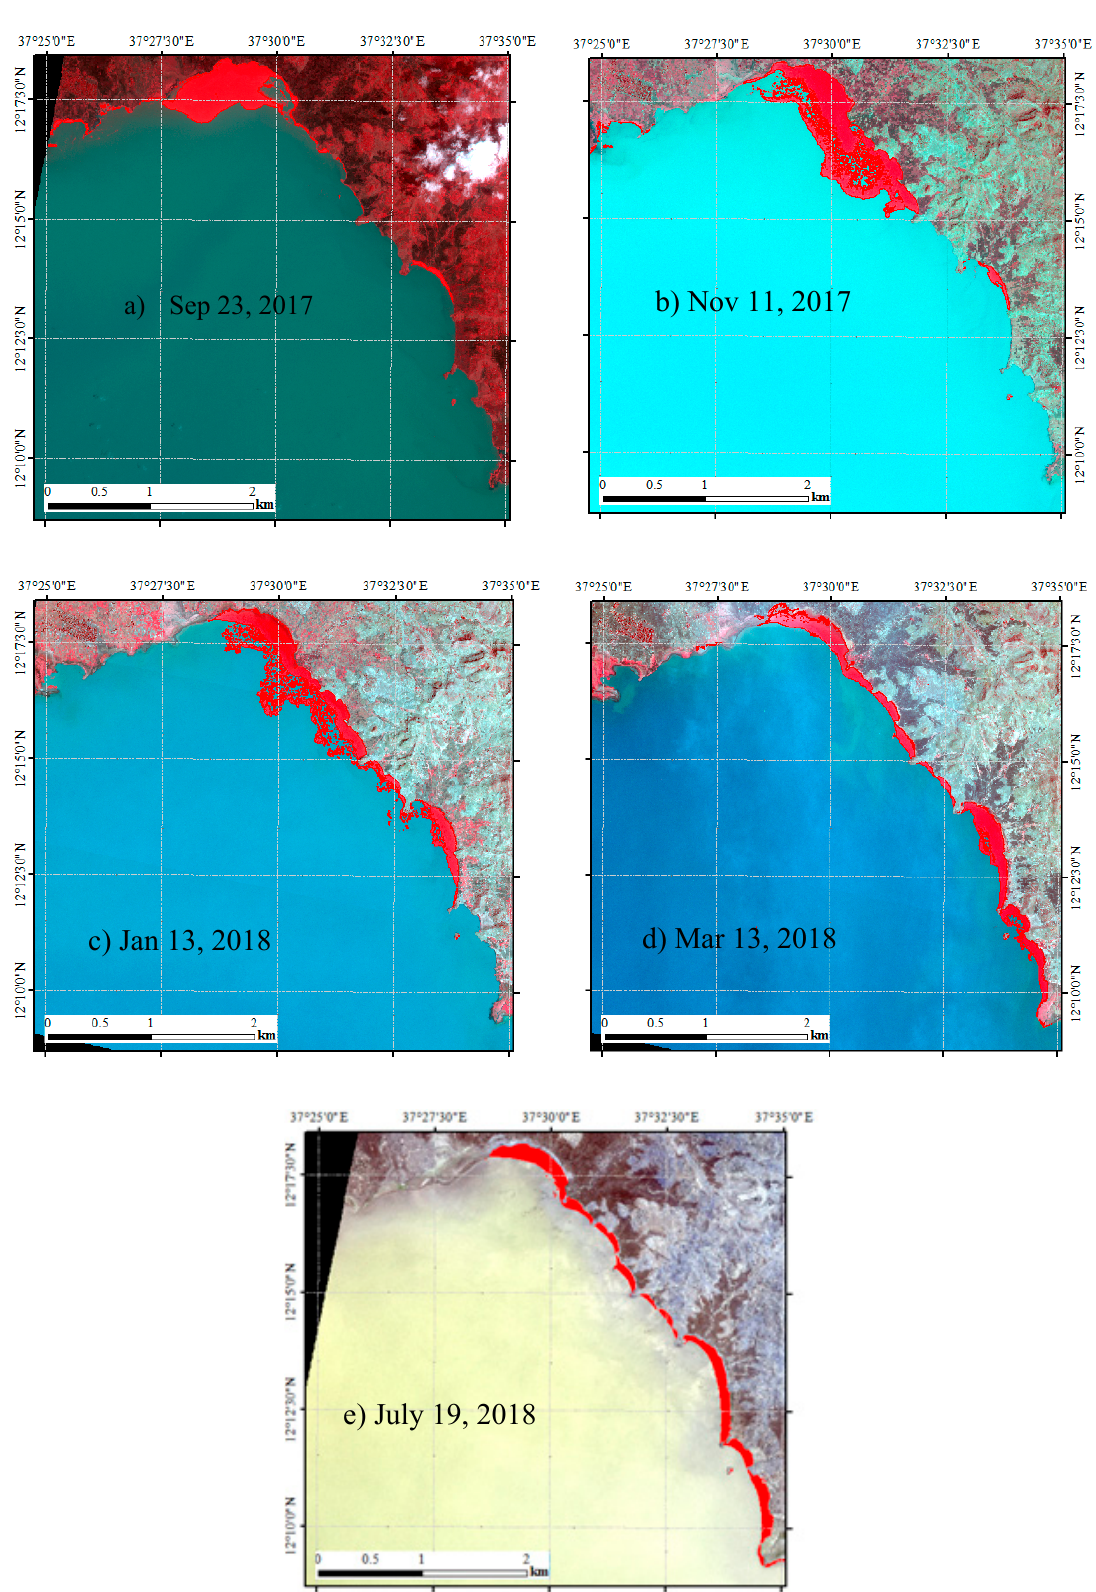
Figure 7. A false-color composite of PlanetScope image and spatial location of the water hyacinth infested area. Supervised classification of ( a ) September 23, 2017, ( b ) November 11, 2017, ( c ) January 13, 2018, ( d ) March 13, 2018, and ( e ) July 19, 2018. The red color represents the spatial area coverage of the water hyacinth infestation.